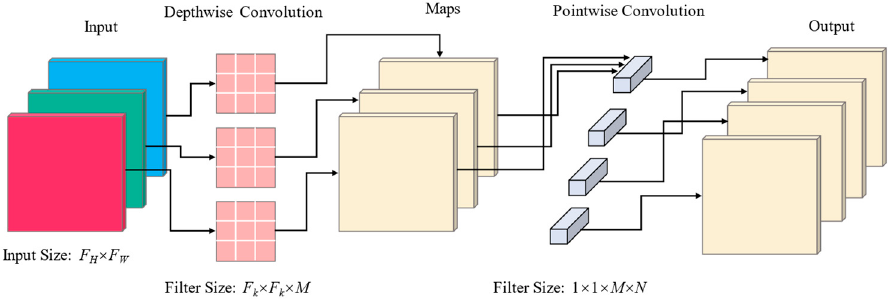
Figure 2. The process of depthwise separable convolution.